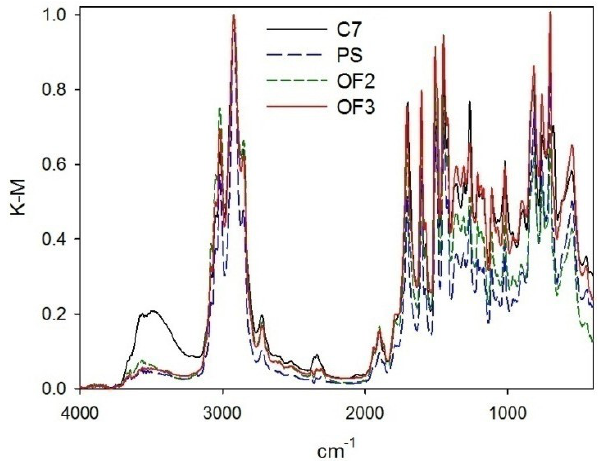
Figure 4. Normalized DRIFT spectra of synthesized